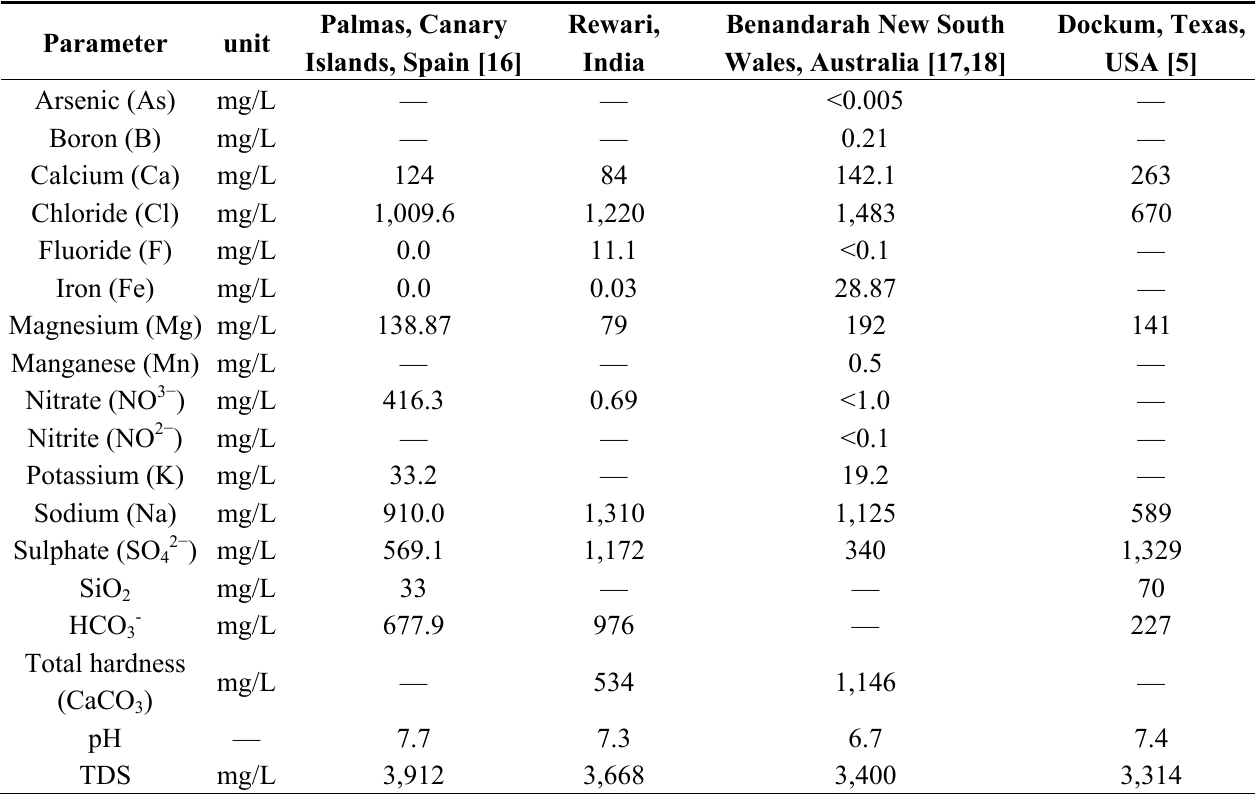
Table 1. Example of brackish water composition from different locations.